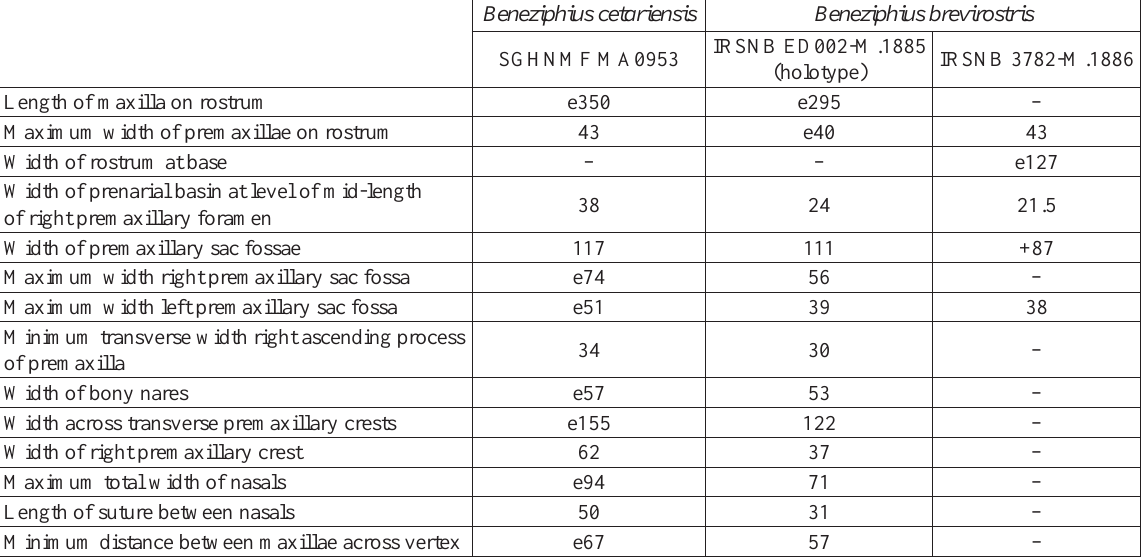
Table 1. Measurements (in mm) of the cranium of Beneziphius cetariensis sp. nov. holotype (SGHNMF MA0953) compared to B. brevirostris . e, estimate, + incomplete, – missing data. Part of the measurements for B. brevirostris taken from Lambert